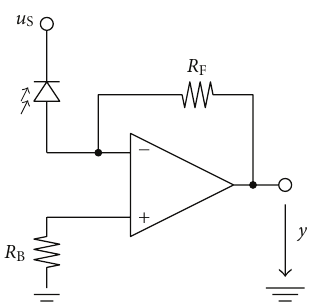
Figure 5: Circuitry used for the amplification of the photodiode current.